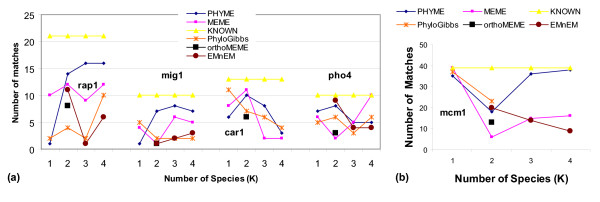
Effect of multiple species information on motif-discovery in the regulons RAP1, MIG1, CAR1, PHO4 and MCM1 in yeast. The y-axis plots the number of matches to the known motif, among the top η reported occurrences, where η is the number of known sites, plotted as "KNOWN" . Only matches in S. cerevisiae are considered.